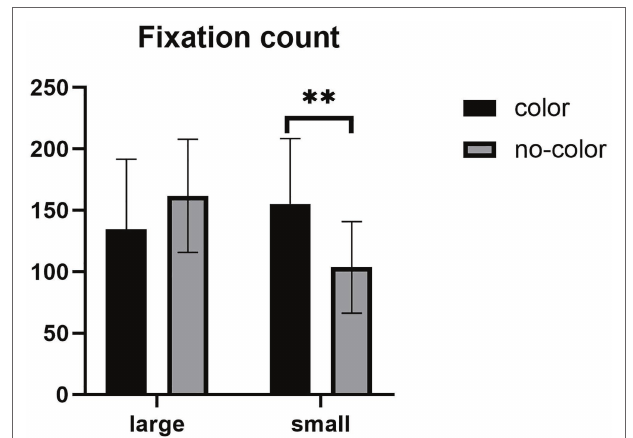
FIGURE 5 | Mean of fixation count. Error bars represent standard errors of the means ( ** p < 0.01).